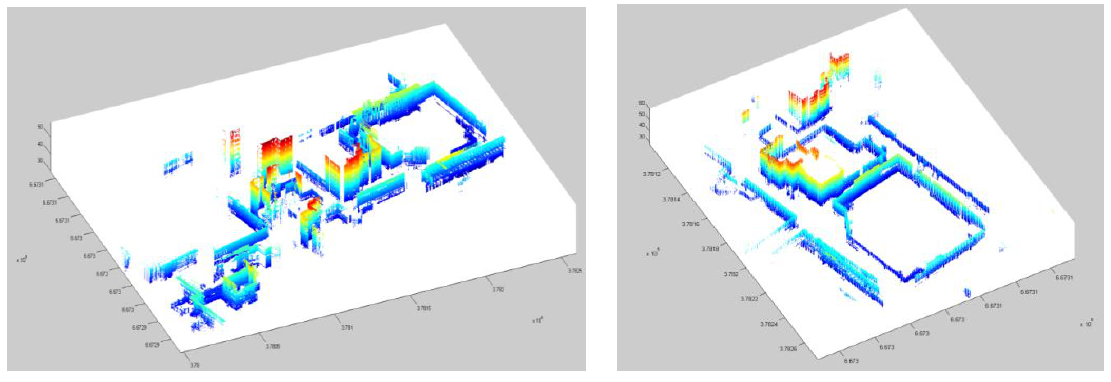
Figure 11. The results from building point classification (The colors show different